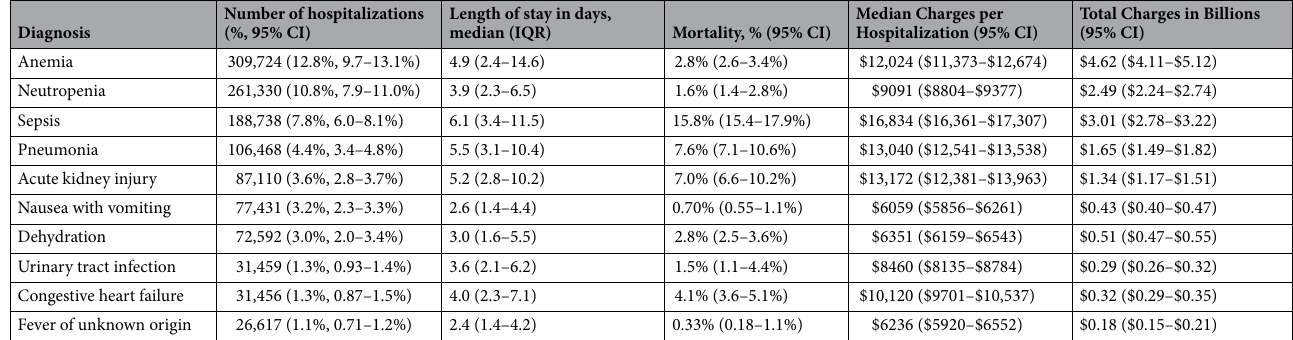
Table 2. Number of hospitalizations, hospital length of stay, in-hospital mortality, and charges for the top 10 complications of systemic therapy, 2005–2016 (n =